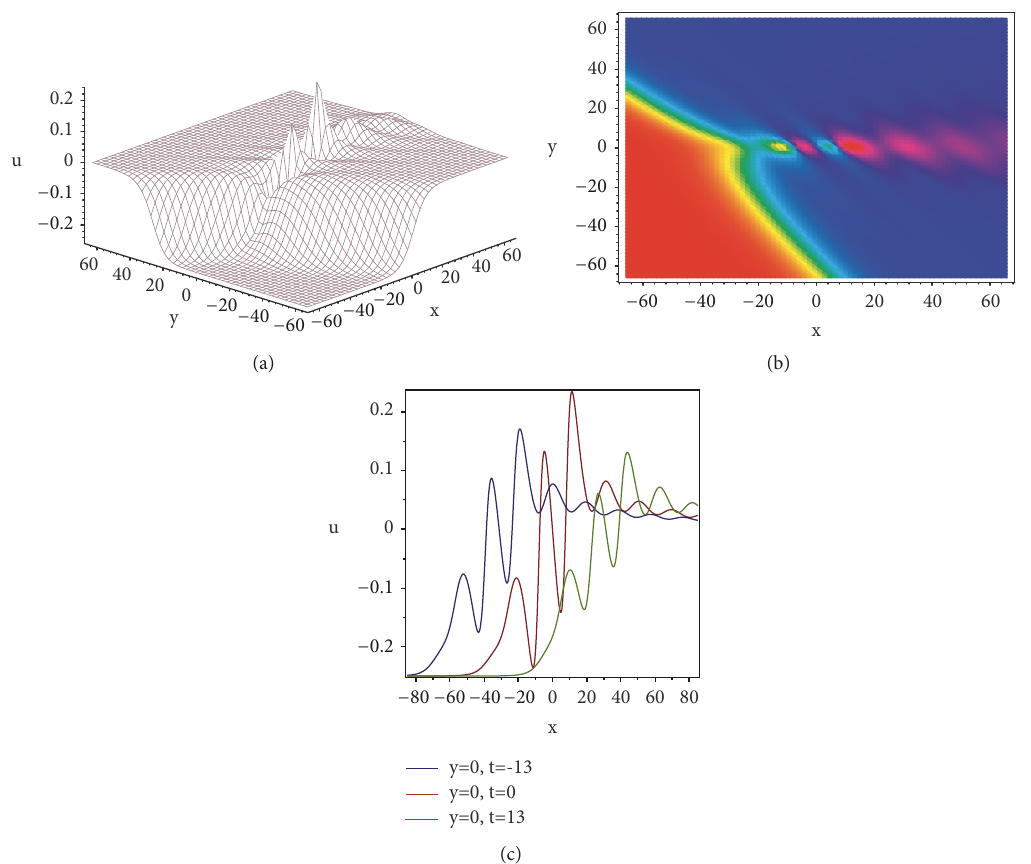
Figure 3: Profile of the interaction among a lump wave, triangular periodic waves, and one-kink soliton in (32). (a) 3-dimensional plot with 𝑡 = 0 , (b) the corresponding density plot, and (c) the curve plot at various values of time.